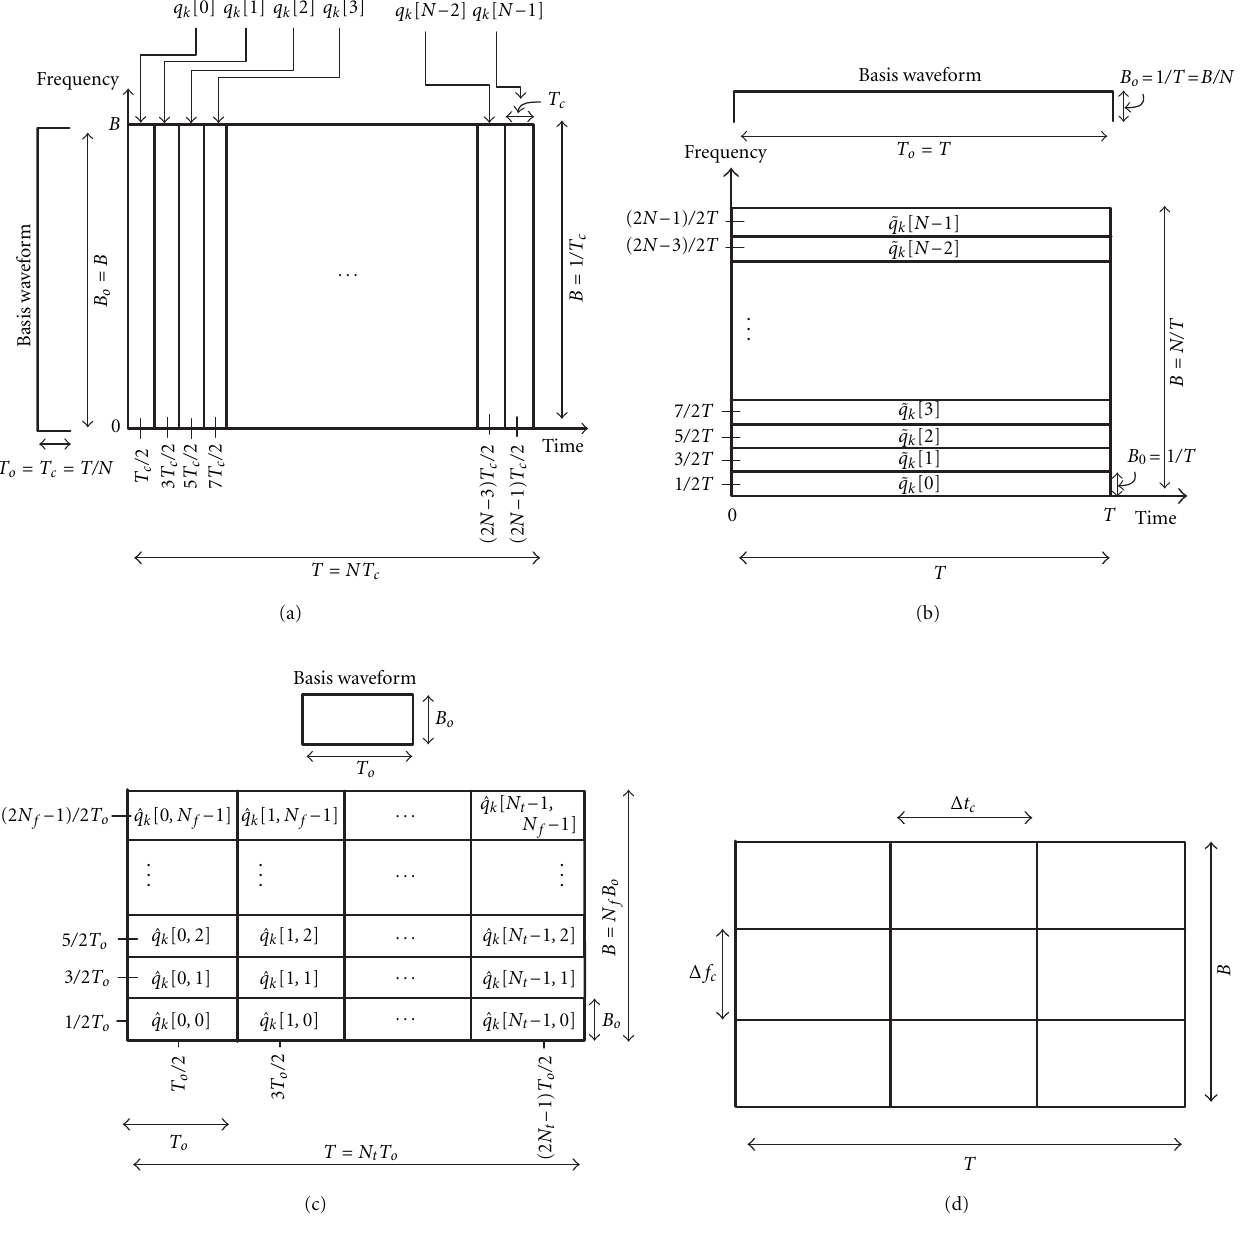
Figure 2: Time-frequency distribution of (a) signature code in DS-CDMA system, (b) signature code in MC-CDMA system, (c) signature code in MC-DS-CDMA system, and (d) channel coherence time and